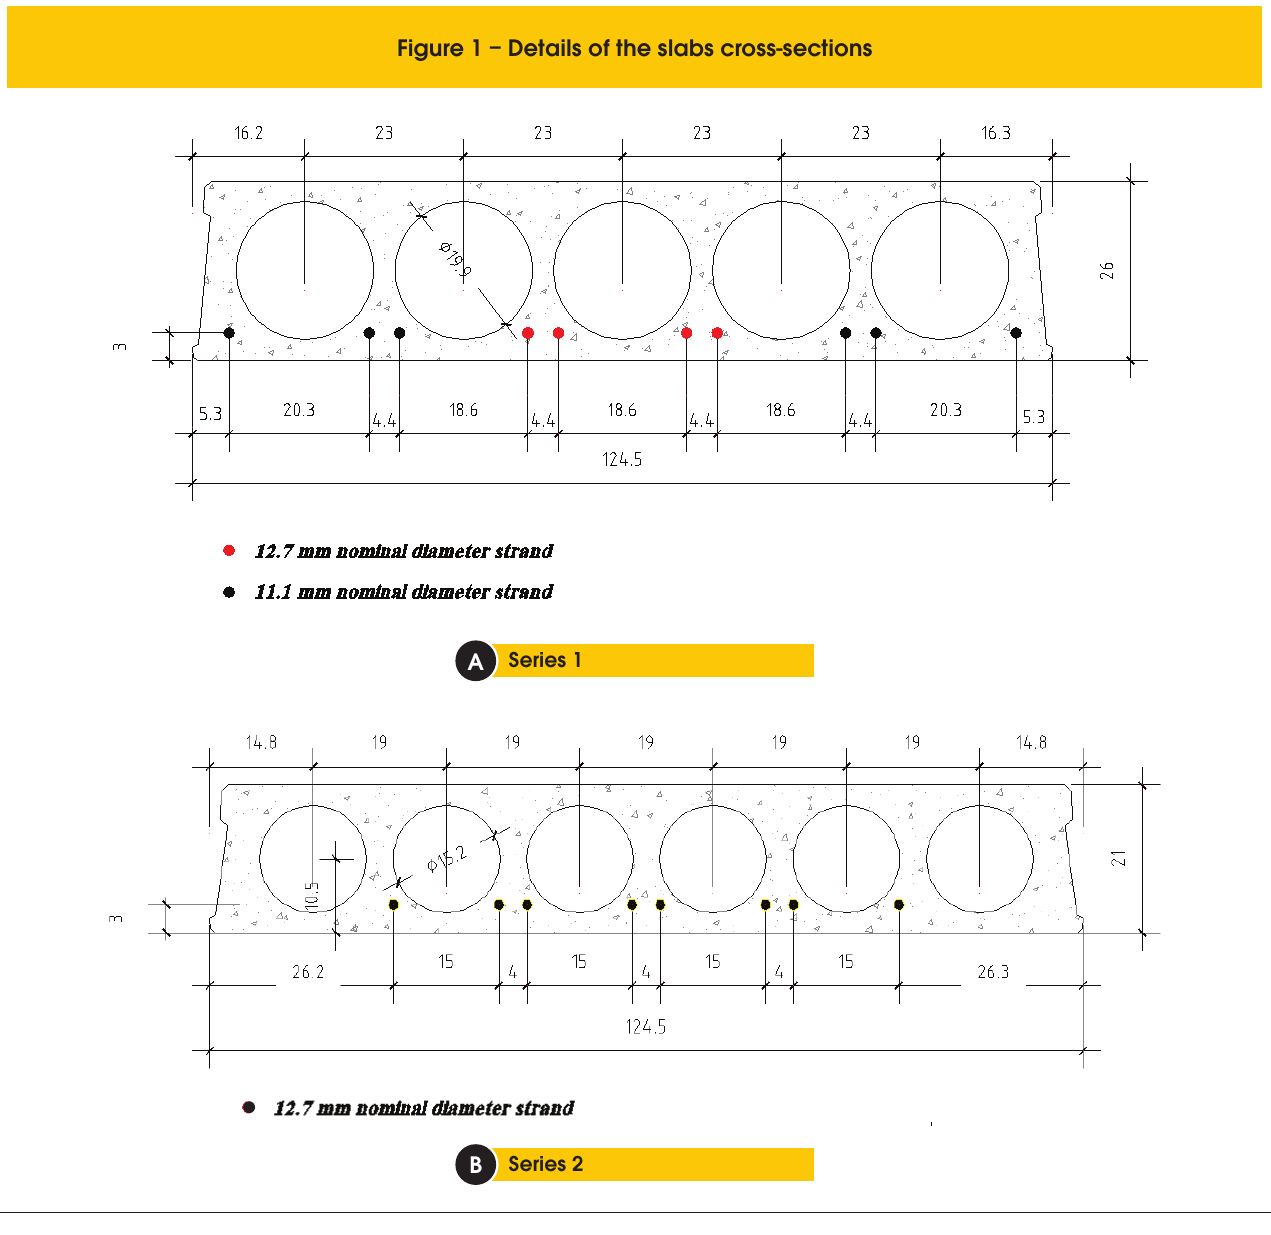
Figure 1 – Details of the slabs